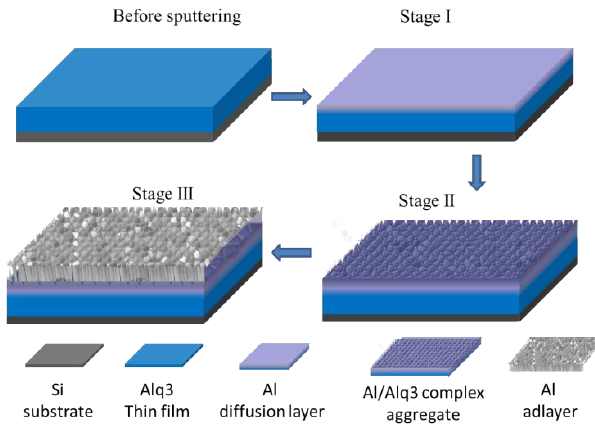
Figure 7. Sputter deposition of Al on Alq3. Three-step growth mechanism similar to Stranski-Krastanov growth for Al, sputter deposited on Alq3. The three stages correspond to the establishment of an enrichment layer with no cluster structures (Stage I), cluster growth on top of the enrichment layer (Stage II), and subsequent columnar growth (Stage III) with increasing Al layer thickness. Reproduced with permission from [168]. Copyright American Chemical Society, 2013.